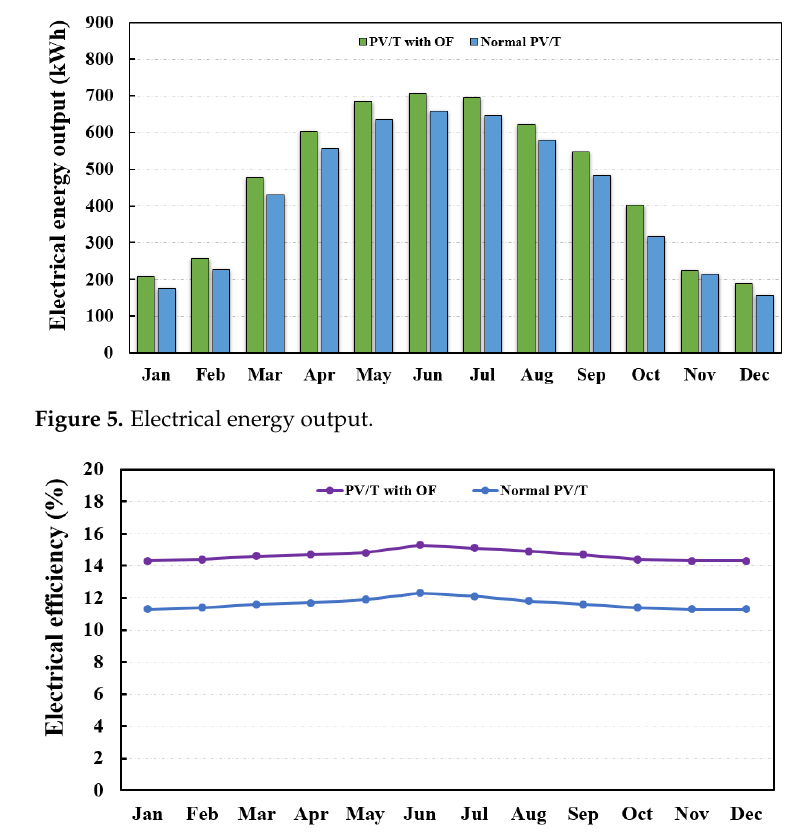
Figure 7. Thermal energy output. Figure 8. Thermal efficiency.